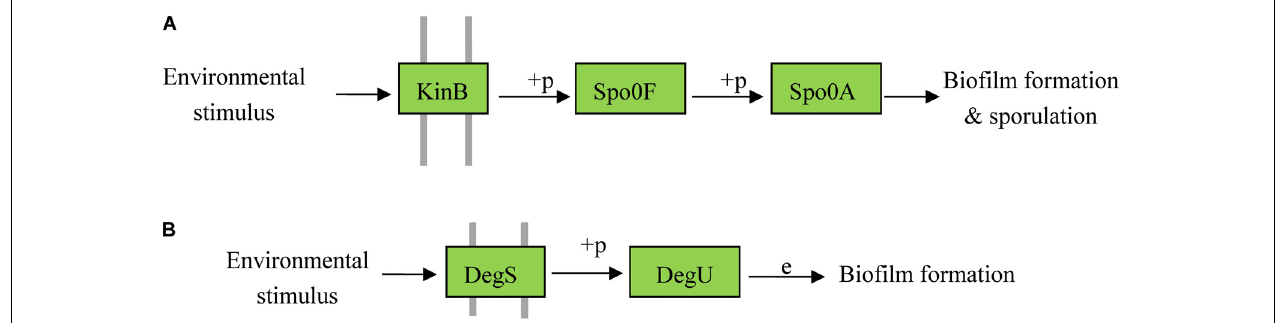
FIGURE 6 | Possible pathways of biofilm formation in P. polymyxa . (A) Pathway A. (B) Pathway B.